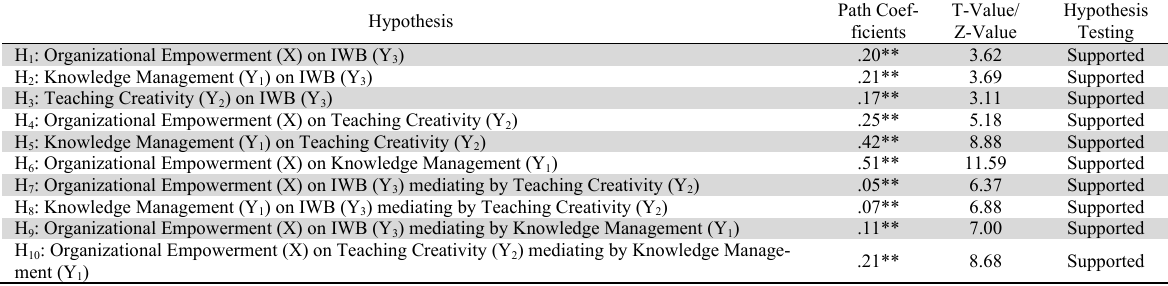
Summary of Path Coefficients and T-values/Z-values